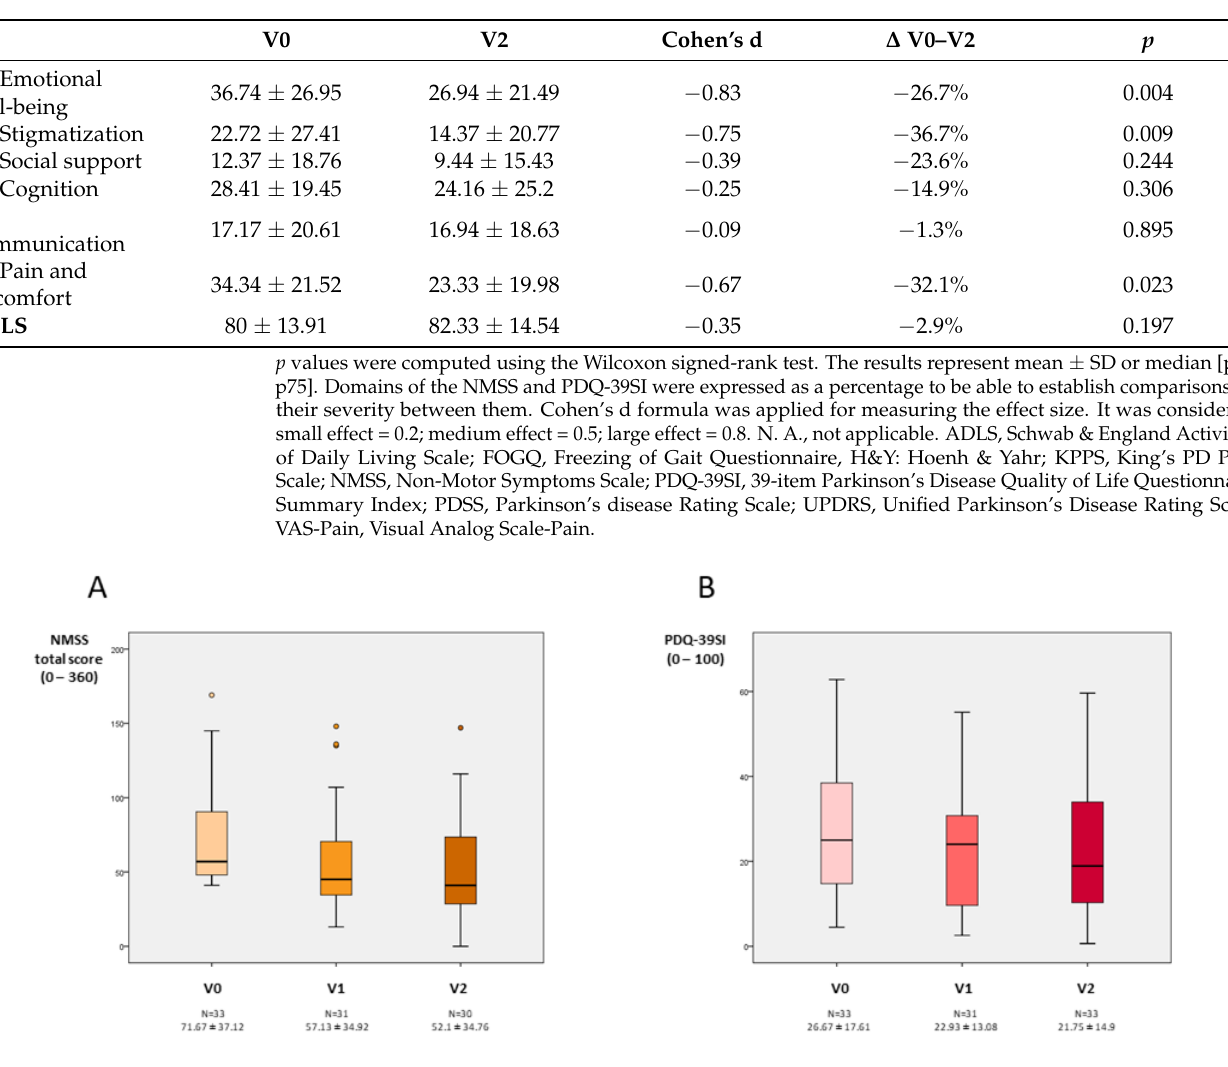
Figure 2. ( A ). Mean score on each domain of the NMSS scale at V0 (baseline), V1 (2 months ± 15 days), and V2 (6 months ± 30 days). The difference between V2 and V0 was significant for NMSS-2 (Sleep/fatigue) ( p < 0.0001), NMSS-3 (Mood/apathy) ( p < 0.001), NMSS-6 (Gastrointestinal symp- toms) ( p = 0.029), and NMSS-9 (Miscellaneous) ( p = 0.021). ( B ). Mean score on each domain of the PDQ-39SI at V0, V1, and V2. The difference between V2 and V0 was significant for PDQ-39SI-3 (Emotional well-being) ( p = 0.004), PDQ-39SI-4 (Stigmatization) ( p = 0.009), and PDQ-39SI-8 (Pain and discomfort) ( p = 0.023). p values were computed using the Wilcoxon signed-rank test.